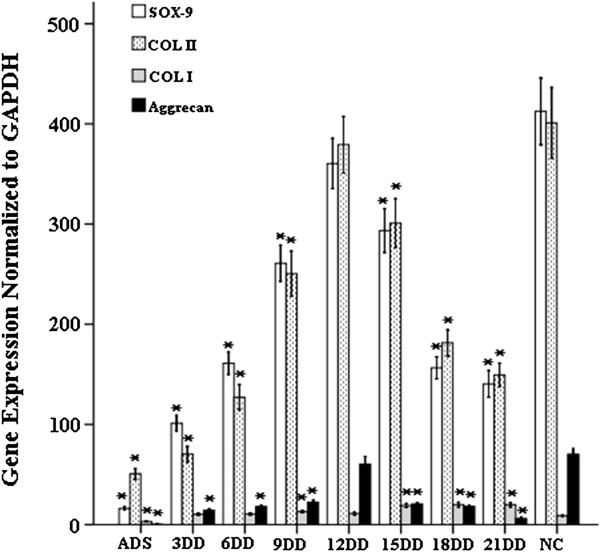
Gene expression analysis during chondrogenesis of ADSCs. ADSCs were cultured for up to 21 days. RNA extracts at day 0, 3, 6, 9, 12, 15, 18, and 21 were analyzed for gene expression of SOX9, COL II, COL I, and Aggrecan normalized to NC, respectively. Asterisk indicates P < 0.05 (vs. NC) as determined by one-way analysis of variance.